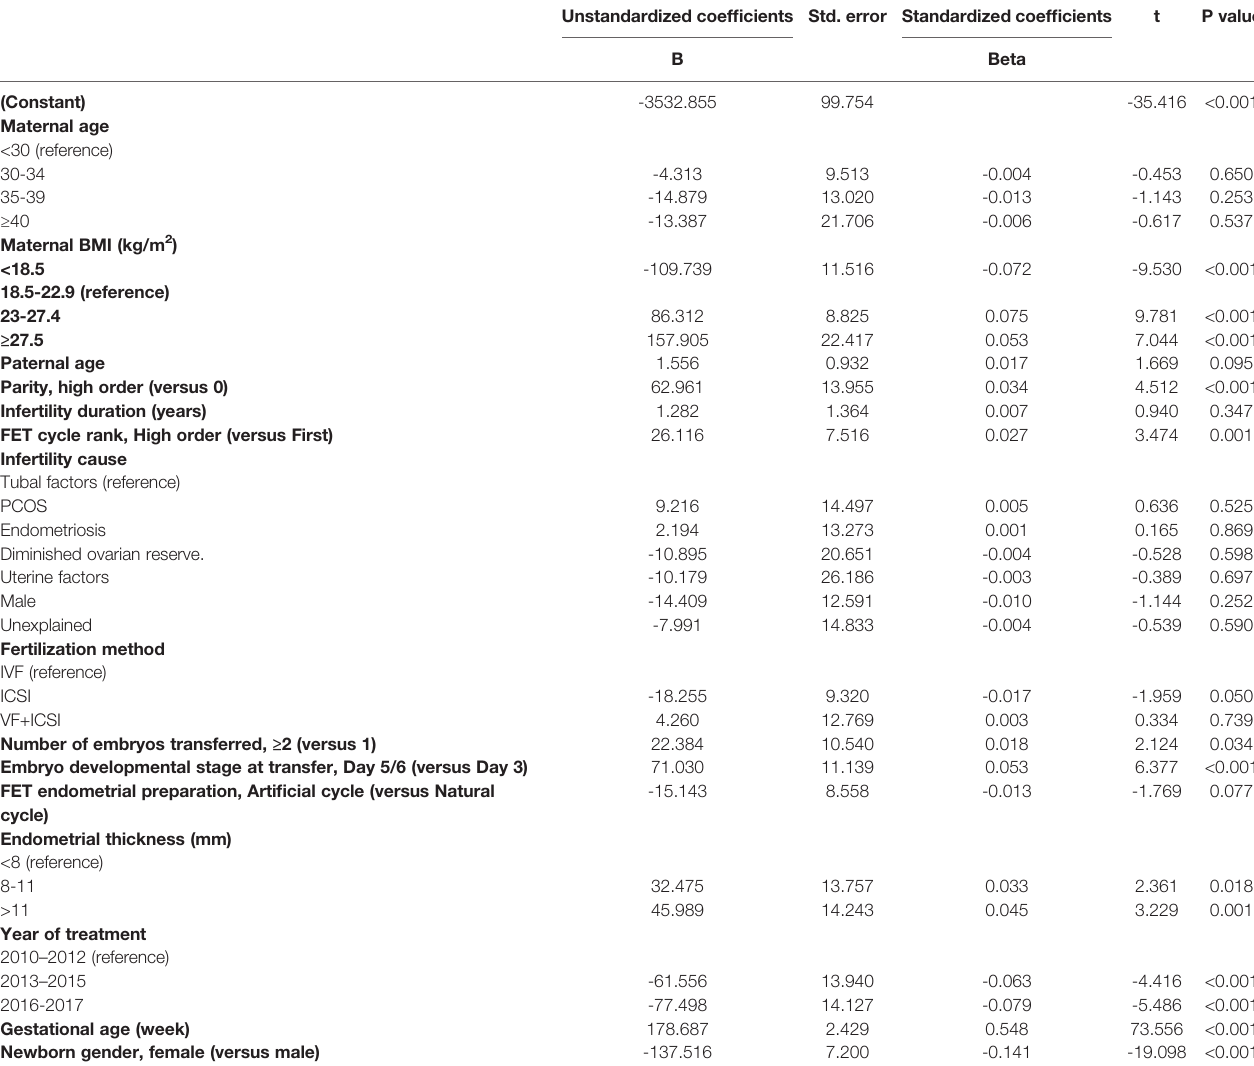
TABLE 4 | Results of multiple regression analysis of singleton